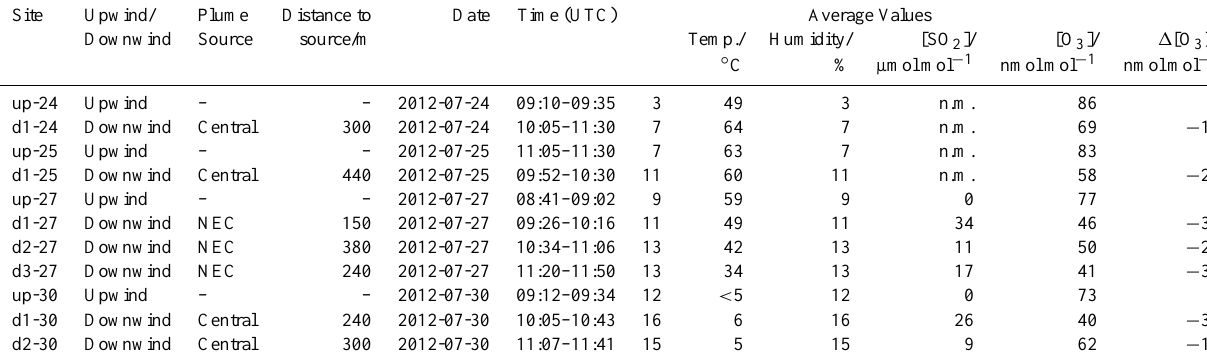
Table 3. Overview of results from Etna summit measurement campaign.